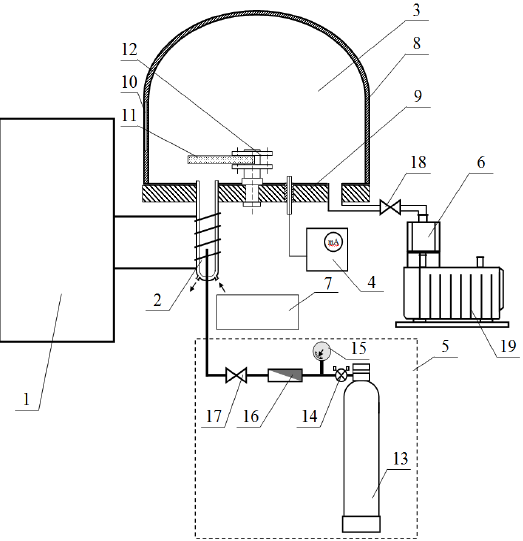
Figure 2. Pilot RF plasma unit operation flowchart: 1—radiofrequency generator; 2—radiofrequency plasma torch; 3—operation chamber; 4—diagnostic monitoring equipment; 5—plasma gas supply control system; 6—a pumping system; 7—water supply systems; 8—metal cap; 9—plate; 10—viewing window; 11—test material; 12—stationary device (carousels); 13—pressure gas cylinder; 14—reducer; 15—pressure gauge; 16—rotameter; 17—needle leak; 18—valve; 19—pump.